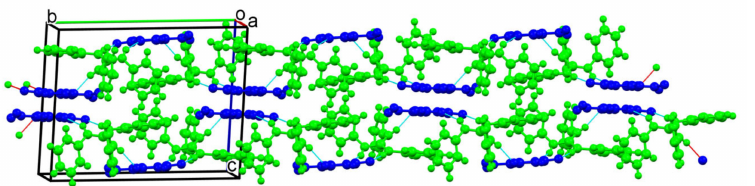
Figure 25. Columnar formation of (XXI) viewed along the a axis. 5NU ions are shown in solid blue, triphenylguanidinium ions are depicted in solid green.